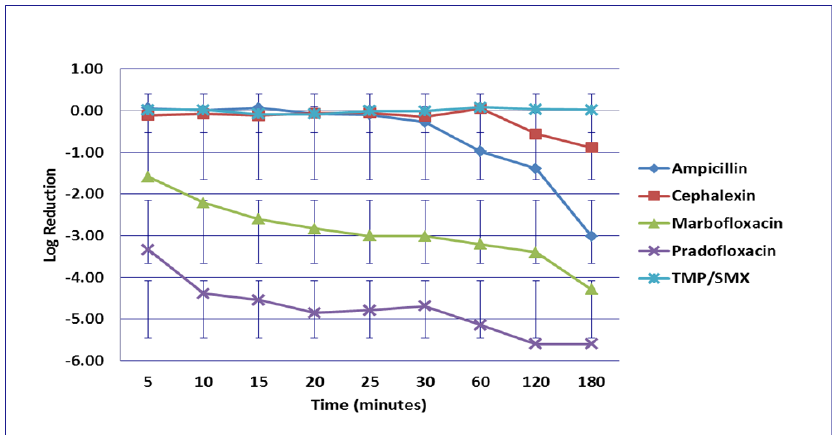
Figure 4. Log 10 reduction in E. coli with bacterial cells exposed to ampicillin, cephalexin, marbofloxacin, pradofloxacin, and trimethoprim/sulfamethoxazole at the maximum urine drug concentration. Pradofloxacin vs. cephalexin at 5, 10, 15, 20, 25, 30, 60, and 120 min, p values <0.0001 for comparison at 5 – 60 min and p = 0.0104 at 120 min. Pradofloxacin vs. TMP/SMX at all time points p = <0.0001 for all comparisons. Pradofloxacin vs. ampicillin at 5, 10, 15, 20, 25, and 30 min, p values <0.0001 to p = 0.0002. Marbofloxacin vs. cephalexin at 5, 10, 15, 20, 25, 30, 60, 120, and 180 min, p values from <0.0001 to 0.0029. Marbofloxacin vs. TMP/SMX at 5, 10, 15, 20, 25, 30, and 60 min, p values from <0.0001 to 0.0002. Marbofloxacin vs. ampicillin at 5, 10, 15, 20, 25 and 30 min, p values from <0.0001 to 0.0002. TMP/SMX vs. ampicillin at 60, 120, and 180 min, p values from <0.0001 to 0.0028. Data points present mean ± standard deviation.